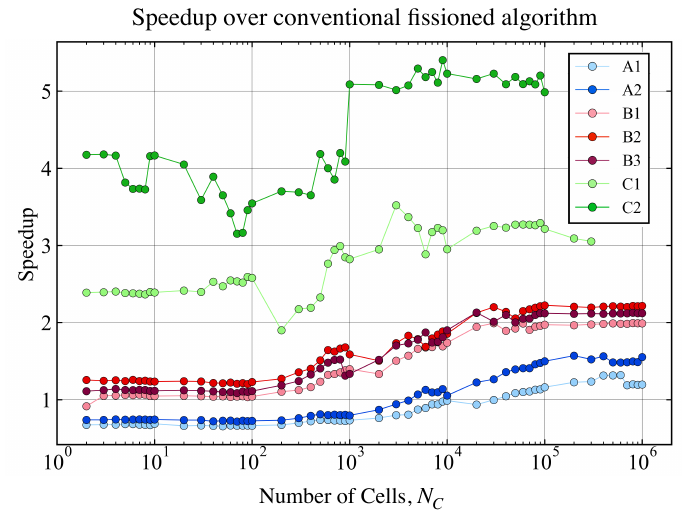
Figure A5. Speedup provided by the matrix-based fissioned algorithm over the conventional fis- sioned counterpart (evaluation times in Figure A4b divided by times in Figure